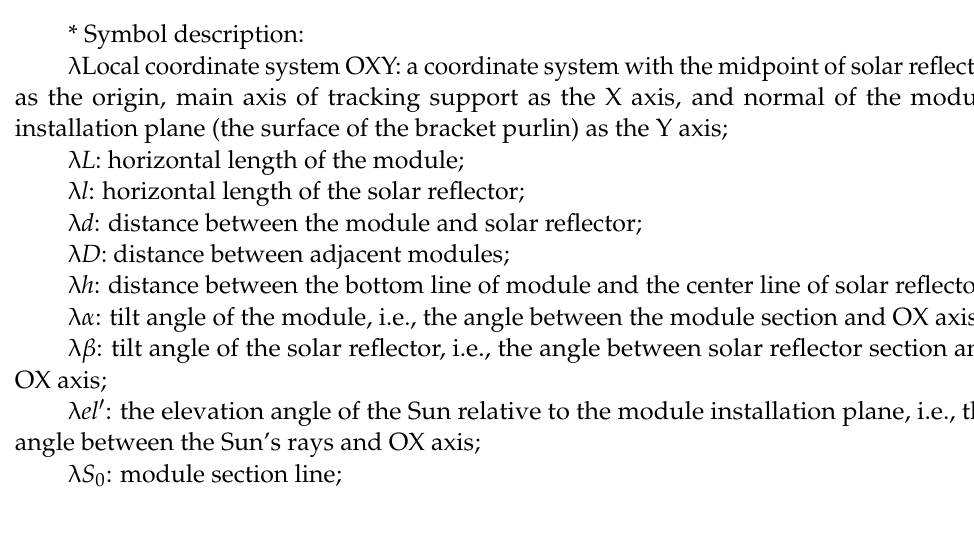
Figure 3. Key parameters of the bifacial companion